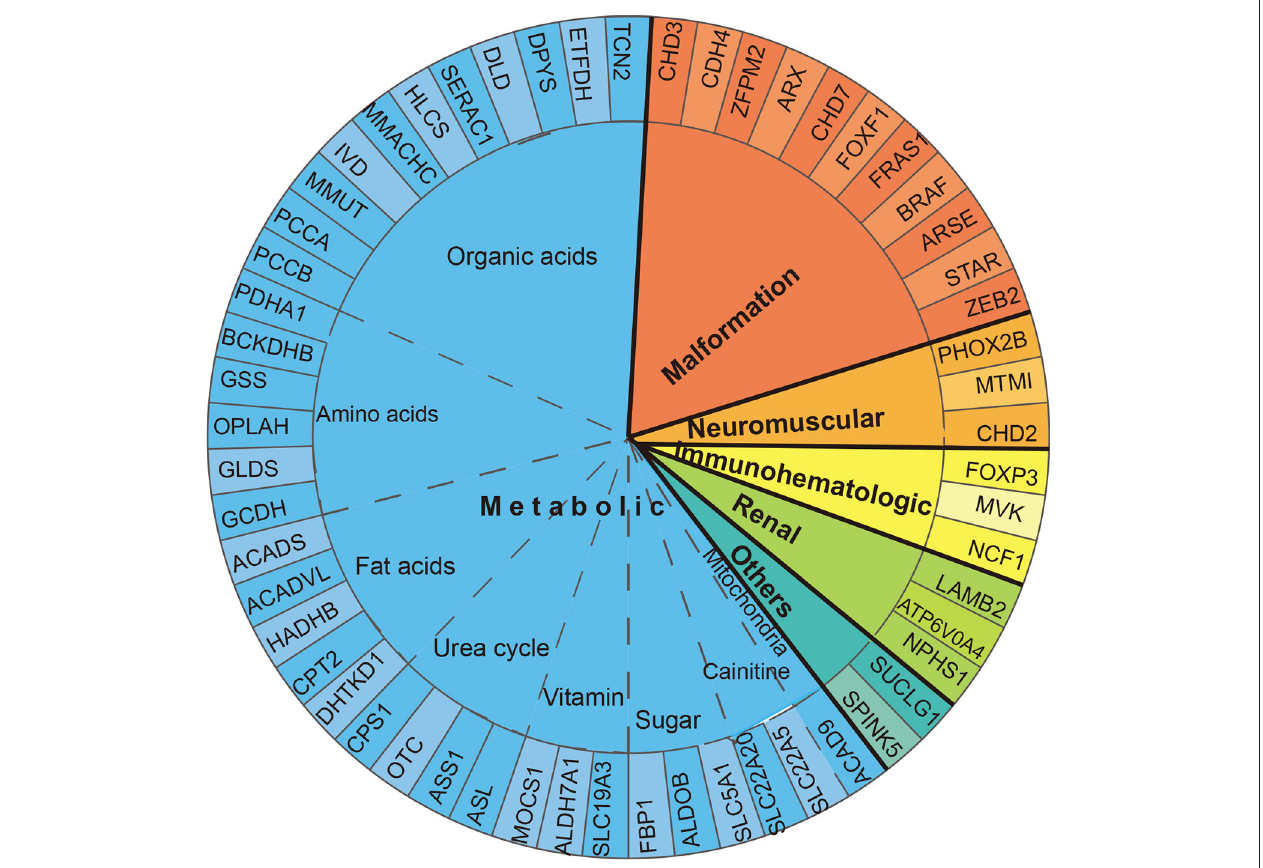
FIGURE 2 | Diagnosed gene distribution according to the disease. Fifty-seven genes are displayed by classification. Thirty-five genes related to metabolic disorder were classified into eight subgroups: organic acid, amino acid, fat acid, urea cycle, sugar, vitamin, carnitine, and mitochondria disorder.